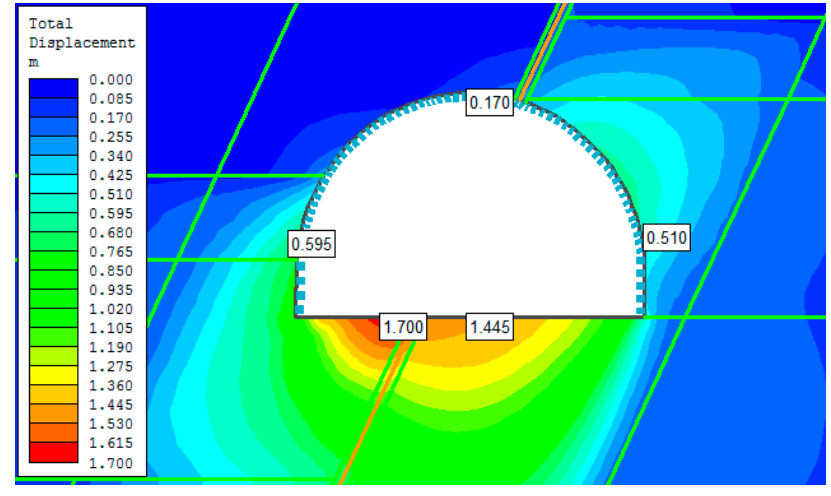
Figure 18. Model no. 8—Maingate D-2 in the fault zone— joint type rock mass and yielding arch support—the map of total displacement.